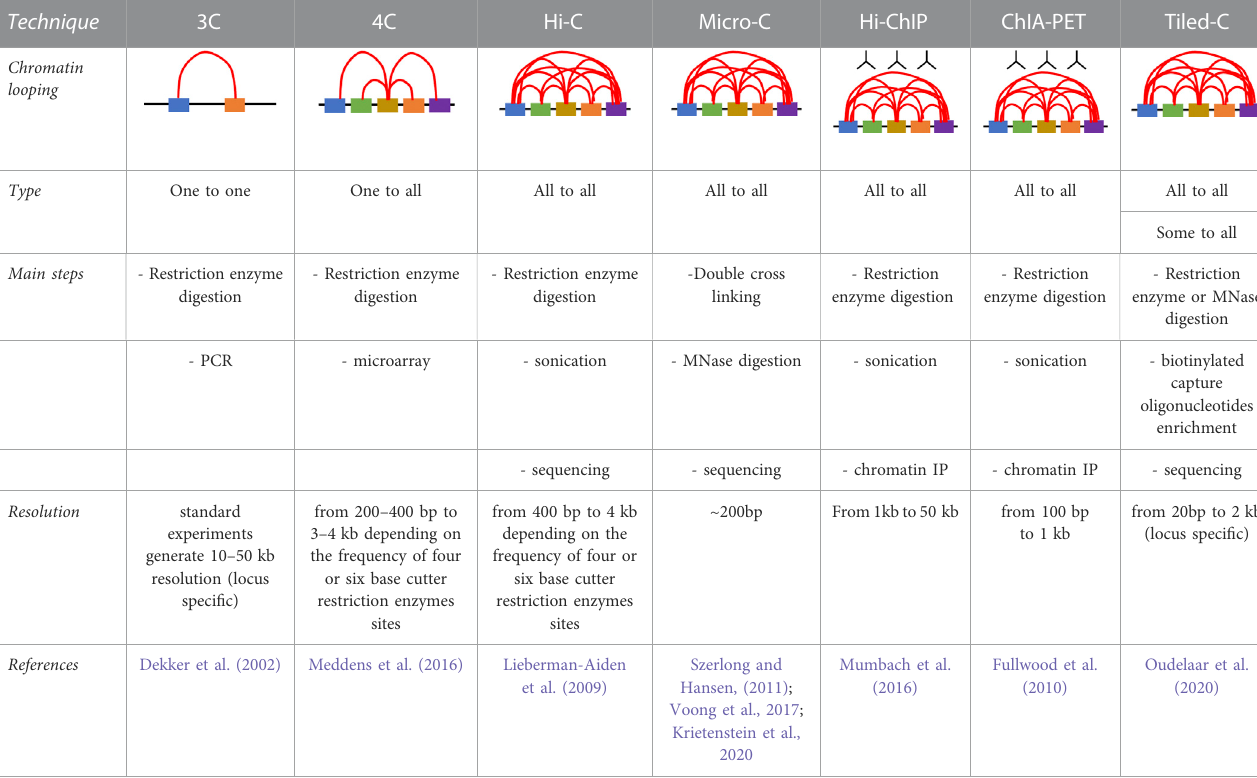
TABLE 1 A summary of the different techniques routinely used to analyse the conformation of the genome.